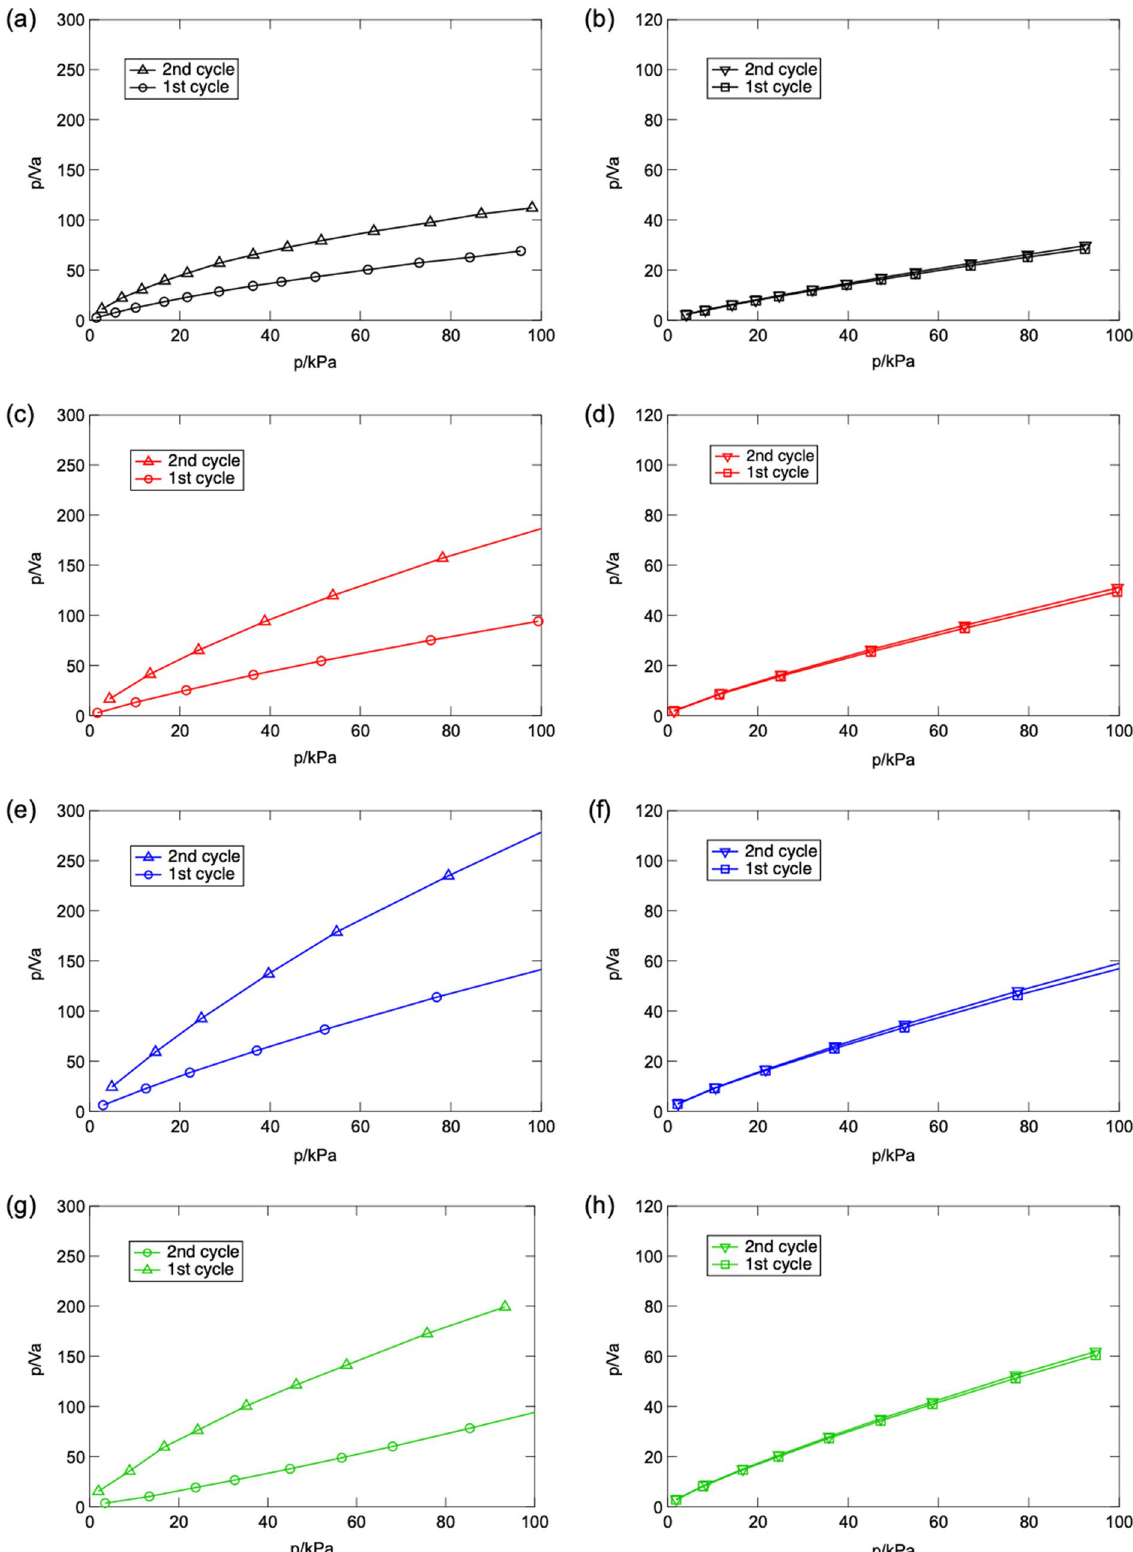
Figure 5. Adsorption isotherms of CO 2 /NH 3 on ( a , b ) raw and mechanochemical treated HAp via ( c , d ) 3 mm, ( e , f ) 10 mm and ( g , h ) 15 mm under different temperatures before (1st cycle) and after (2nd cycle) in-situ vacuum